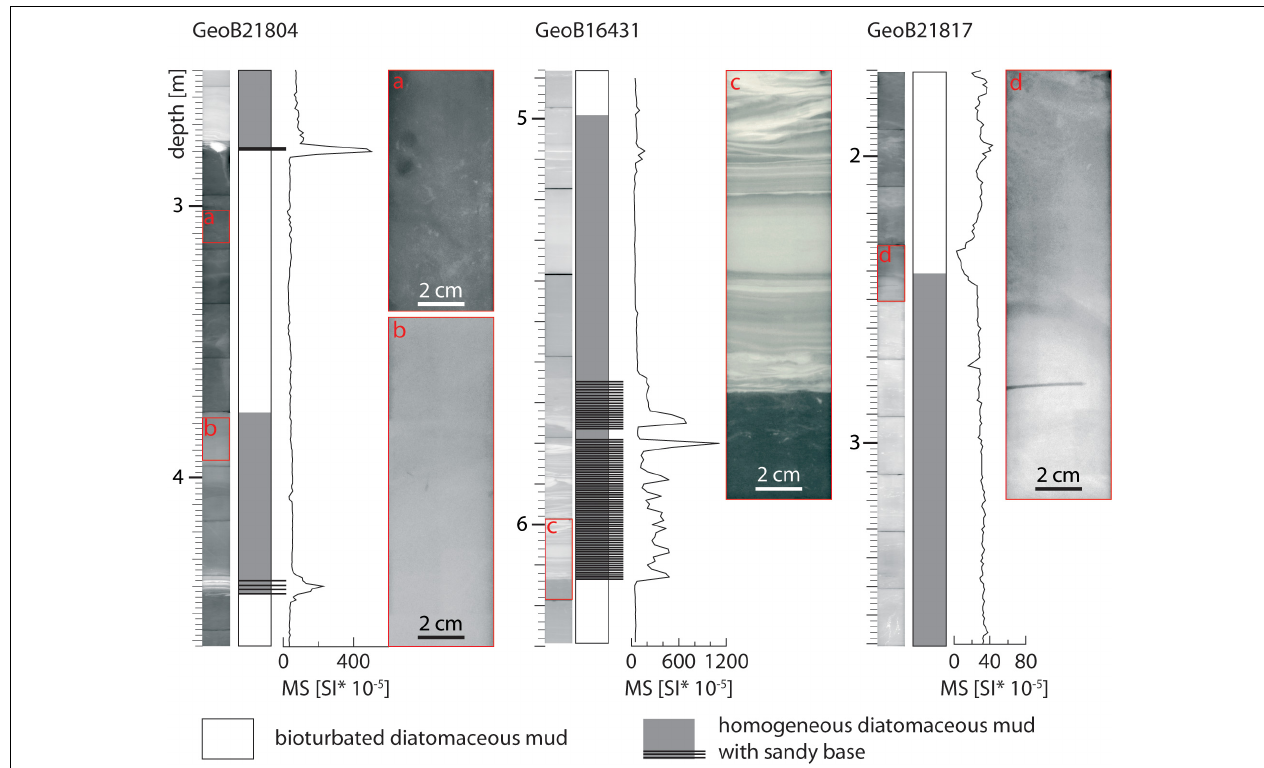
FIGURE 5 | Typical examples of radiographs, photos, and magnetic susceptibility (MS) of sediment cores GeoB21804, GeoB16431, and GeoB21817 in the southern, central, and northern Japan Trench, respectively.